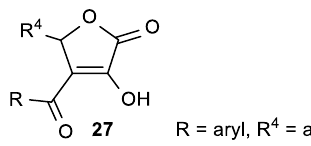
Figure 11. 3-Benzoyl-substituted butenolide derivatives. Table 7. The DPPH and superoxide anion scavenging activities of 3-benzoyl-substituted butenolides. Comp.